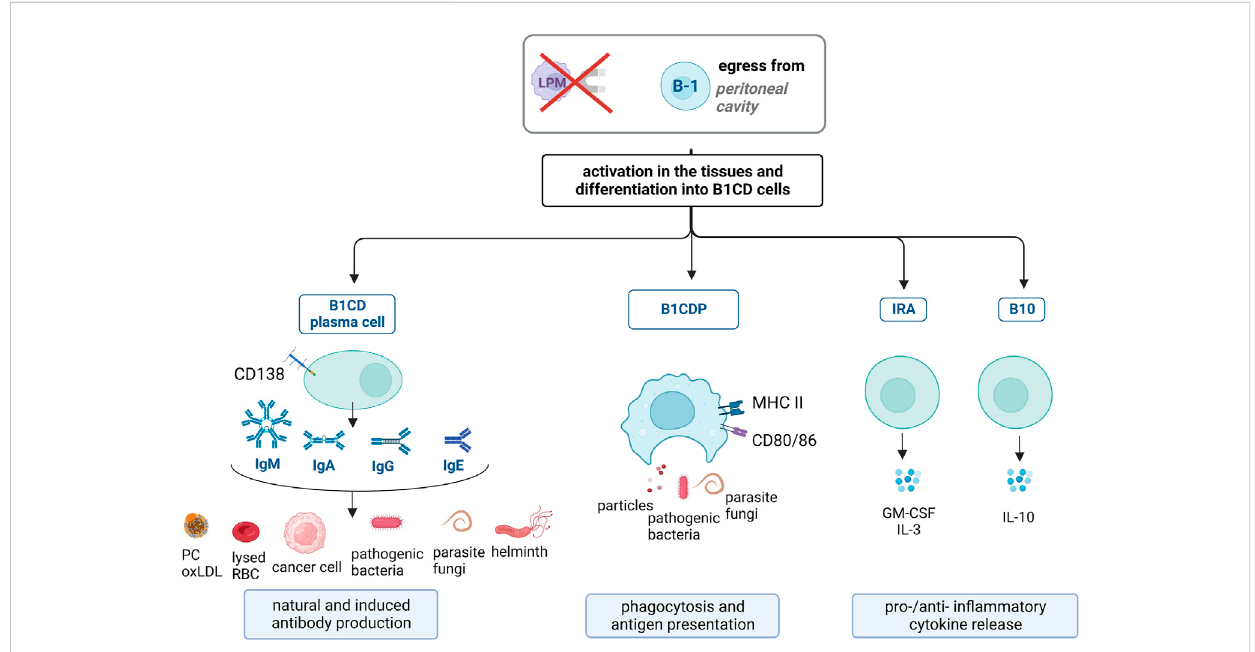
FIGURE 2 B-1cellresponsesinpathologicalconditions.Underpathologicalconditions,B-1cellsleavemesothelialcavitiesandgetactivated.Theydifferentiate into B-1 cell-derived (B1CD) cells, comprising four subpopulations. B1CD plasma cells are CD138 + and release natural antibodies (mostly IgM, with low speci fi city to (self-)antigens, including phosphorylcholine (PC) and oxLDL present on apoptotic cells, lysed red blood cells (RBC) and cancer cells) and induced antibodies (IgM, IgA, IgG, and IgE, with high speci fi city to antigens, including pathogens). B1CD phagocytes (B1CDP) are phenotypically similar to macrophages, phagocytose and present antigens to T cells via MHC II and CD80/CD86. Innate response activator (IRA) release pro- in fl ammatory GM-CSF and IL-3. B10 cells exclusively release immunosuppressive